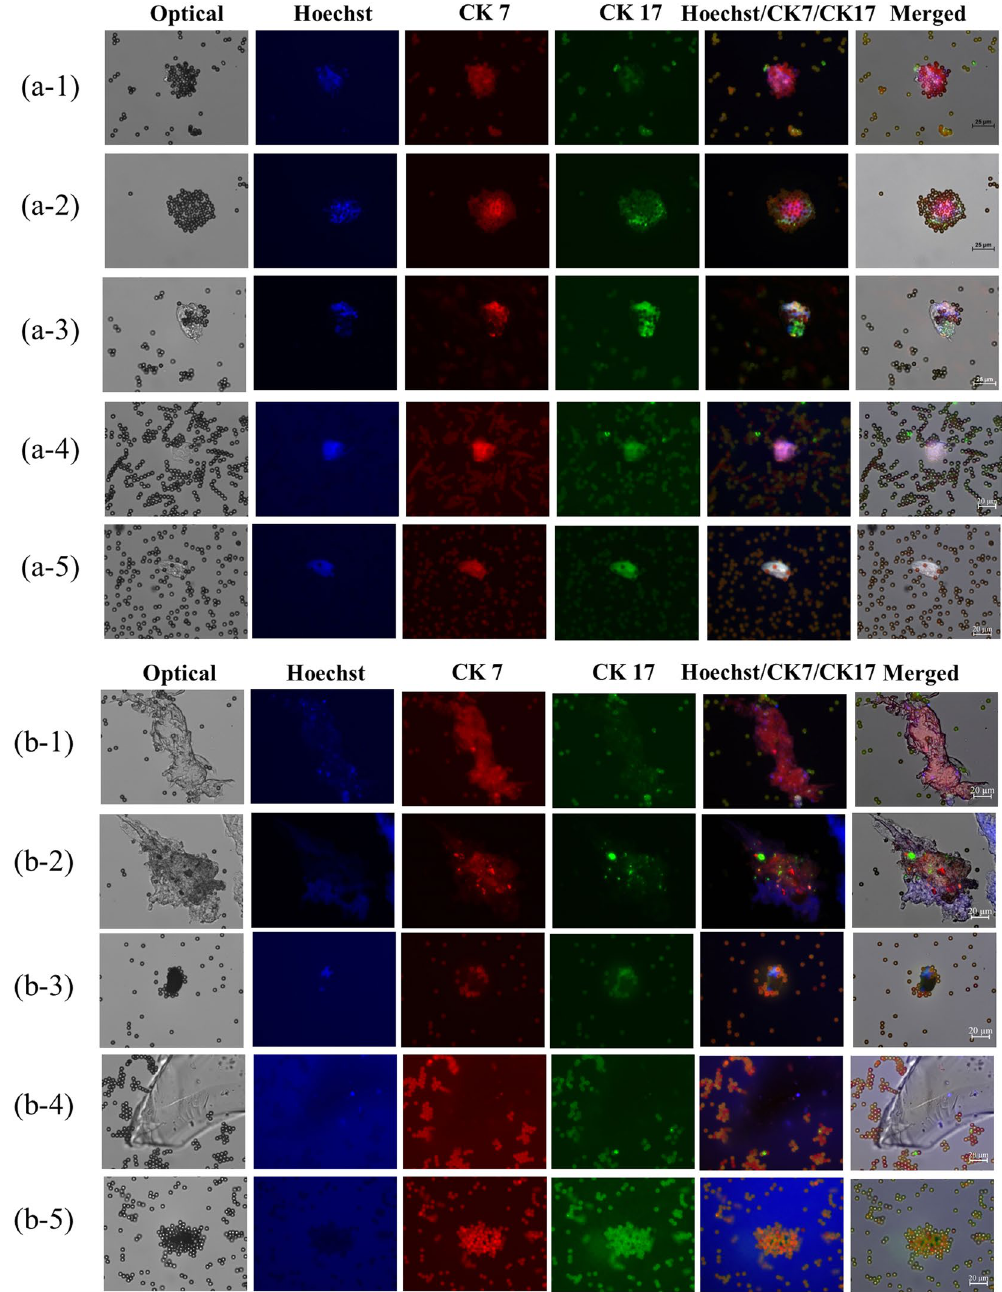
Figure 5. On-chip cholangiocarcinoma (CCA) cell capture and consequent immunofluorescence (IF) staining with CCA-specific biomarkers (CK7 and CK17). Cells were additionally stained with EpCAM and DAPI/ Hoechst. Please note that only cells that presented red (CK7) green,(CK17), and blue (DNA) fluorescence were confirmed to be CCA cancer cells that were captured by EpiEnrich beads. ( a ) Positive CCA cells; ( b ) negative